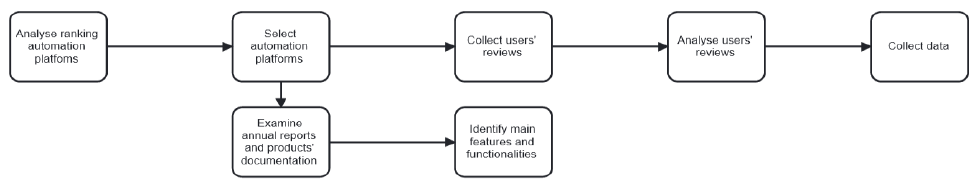
Figure 2. Automation platforms and analysis of leading developers. Source: authors’ construction.